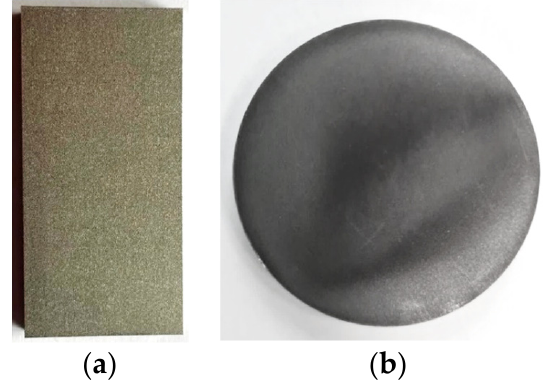
Figure 1. ( a ) DMLS sample; ( b ) as-cast sample.